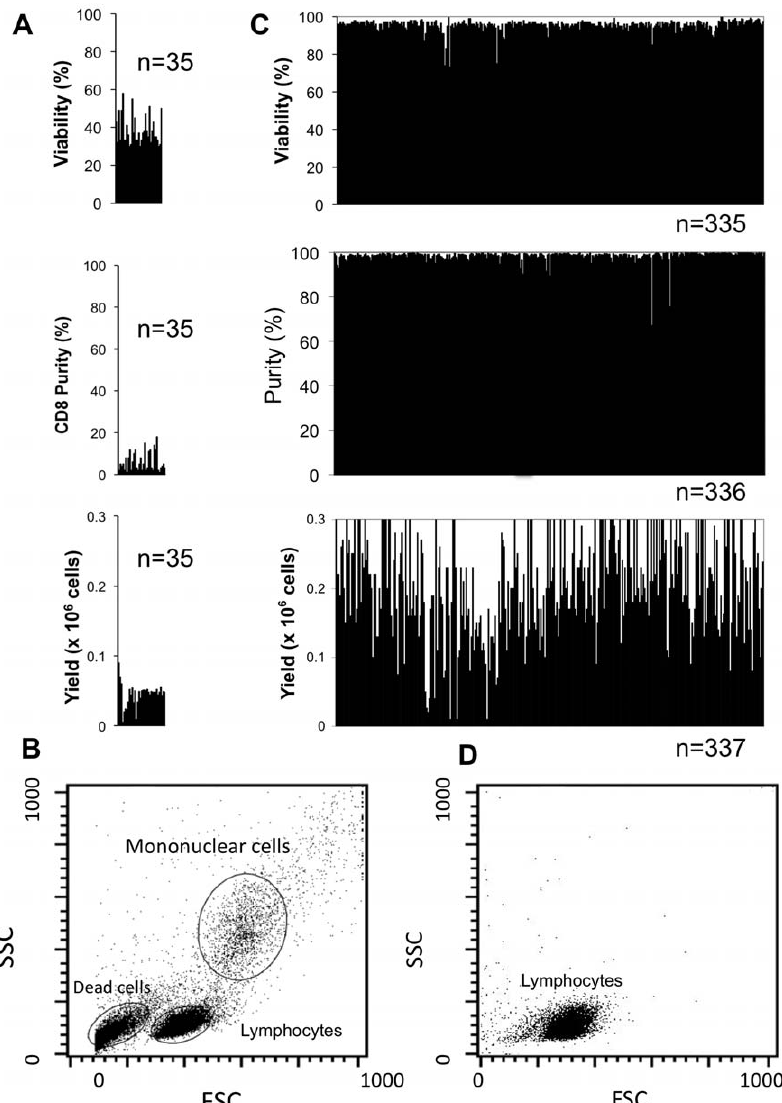
Figure 1. Comparison of accuracy of isolation. In recruited subjects, the accuracy of PBLs or lymphocyte subset (CD8 lymphocytes) isolations from fresh blood was compared between the Ficoll method (N . 35 subjects) (A,B) and the manual magnetic method (N . 335 subjects) (C,D). Accuracy of the isolates was analyzed by viability (A,C), purity (A,C), yield (A,C), and cellular composition by analysis of FSC (forward)/SSC (side) scatter (B,D) from flow cytometry. The Ficoll method (A) was inferior to the magnetic method on viability and purity (C). The magnetic method (C) also generated higher yields but the variability was high, reflecting inherent variability found across healthy subjects. In addition, the cellular composition, as determined by scatter plots (B,D), revealed that the magnetic method isolated the cells of interest, CD8 T cells, whereas Ficoll produced a mix of PBLs sufficiently contaminated with dead cells and mononuclear cells that it would require further purification to detect autoreactive CD8 T cells.